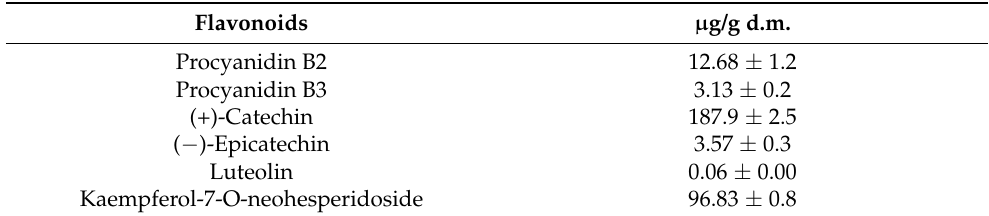
Table 2. Individual flavonoid components identified and quantified in lentil wholemeal flours and expressed as µ g/g dry